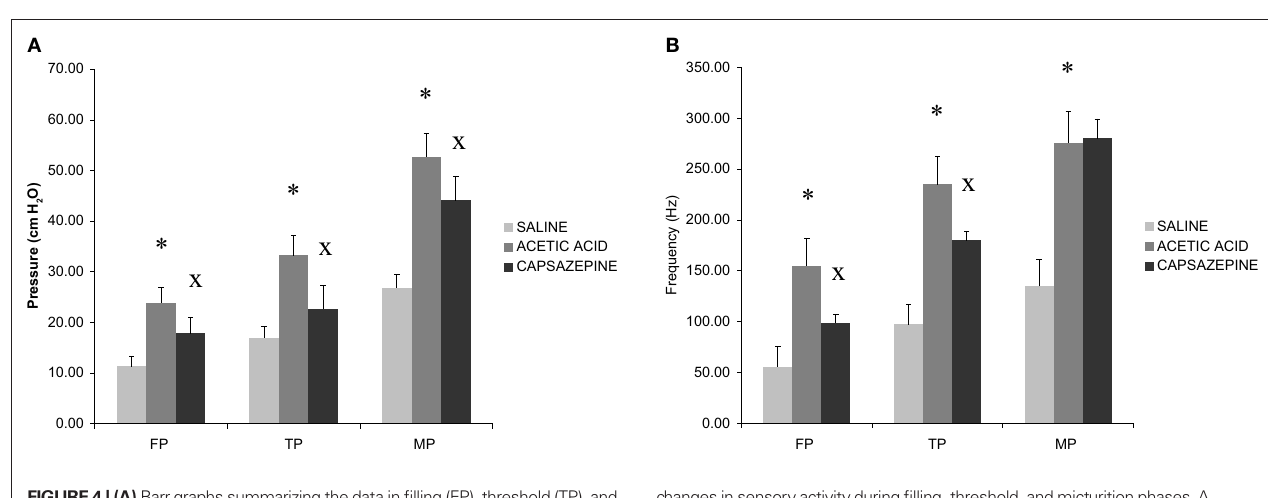
Figure 4 | (A) Barr graphs summarizing the data in filling (FP), threshold (TP), and micturition pressures (MP) (n = 8). A significant increase in all three parameters was observed following the infusion of 0.5% acetic acid. Capsazepine, infused with 0.5% acetic acid, significantly reduced filling and threshold pressures. The (*) mark a significant difference between 0.9% NaCl and 0.5% acetic acid, ( x ) indicate significant difference between 0.5% acetic acid and capsazepine. (B) Summary of